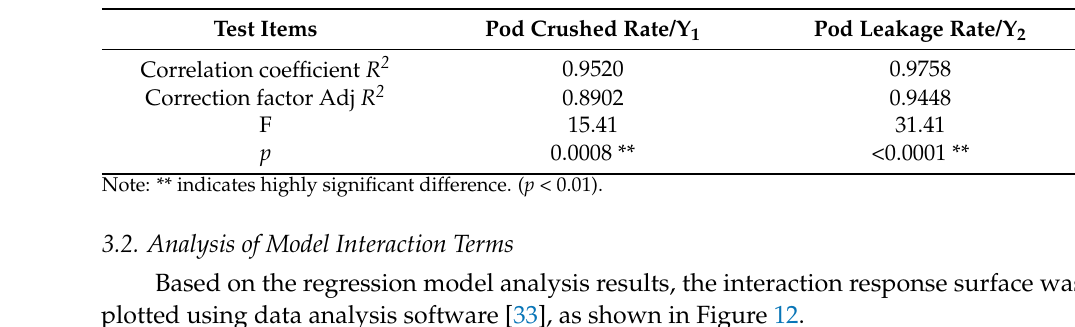
Table 8. Significance analysis of regression coefficient.